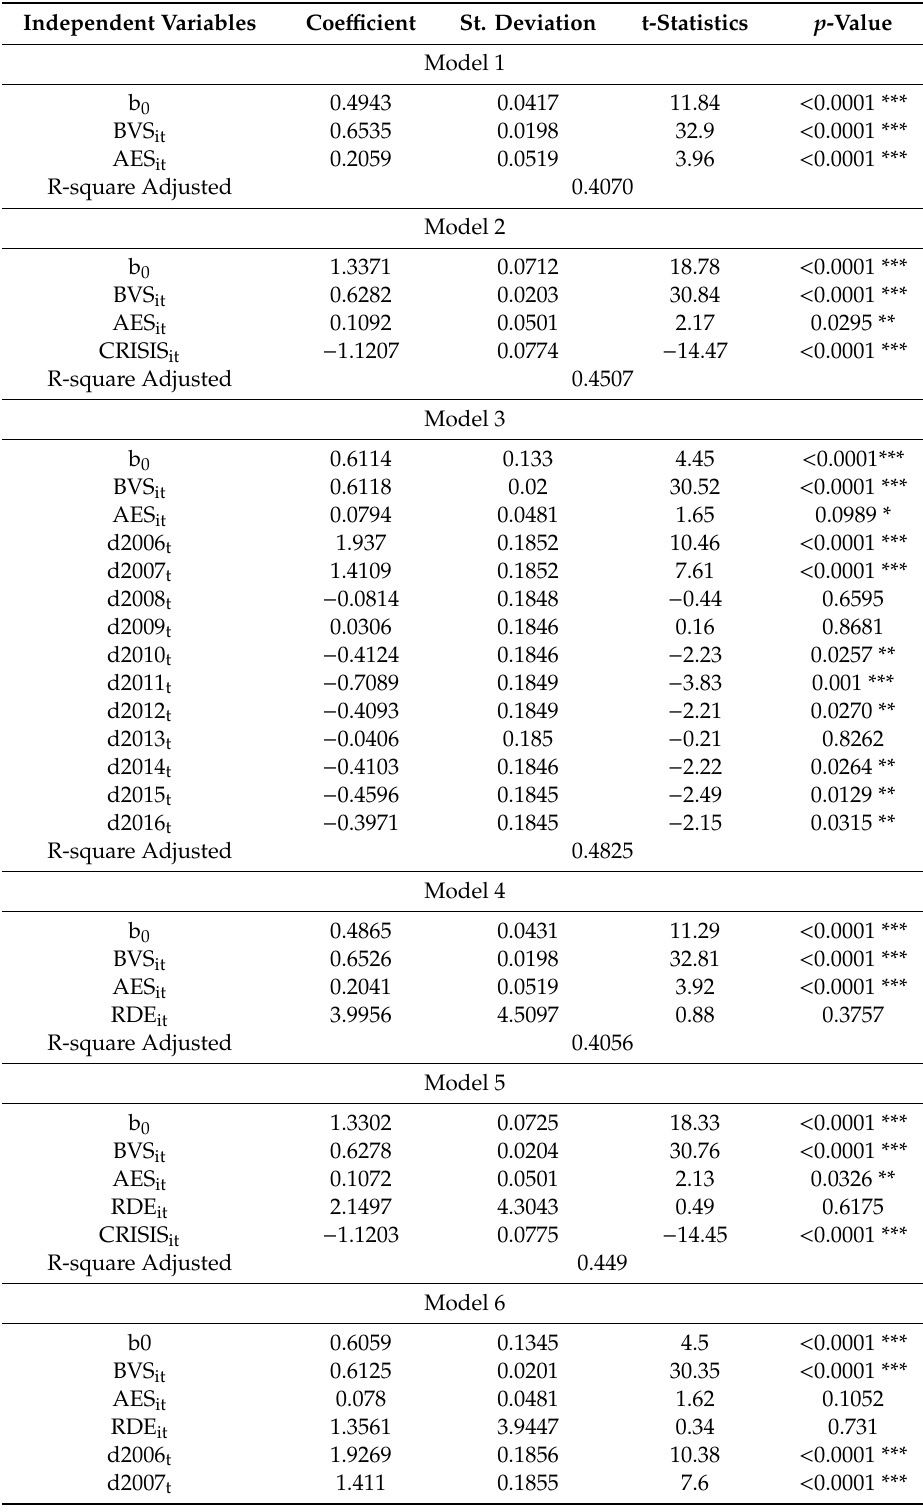
Table 3. Weighted least squares regression